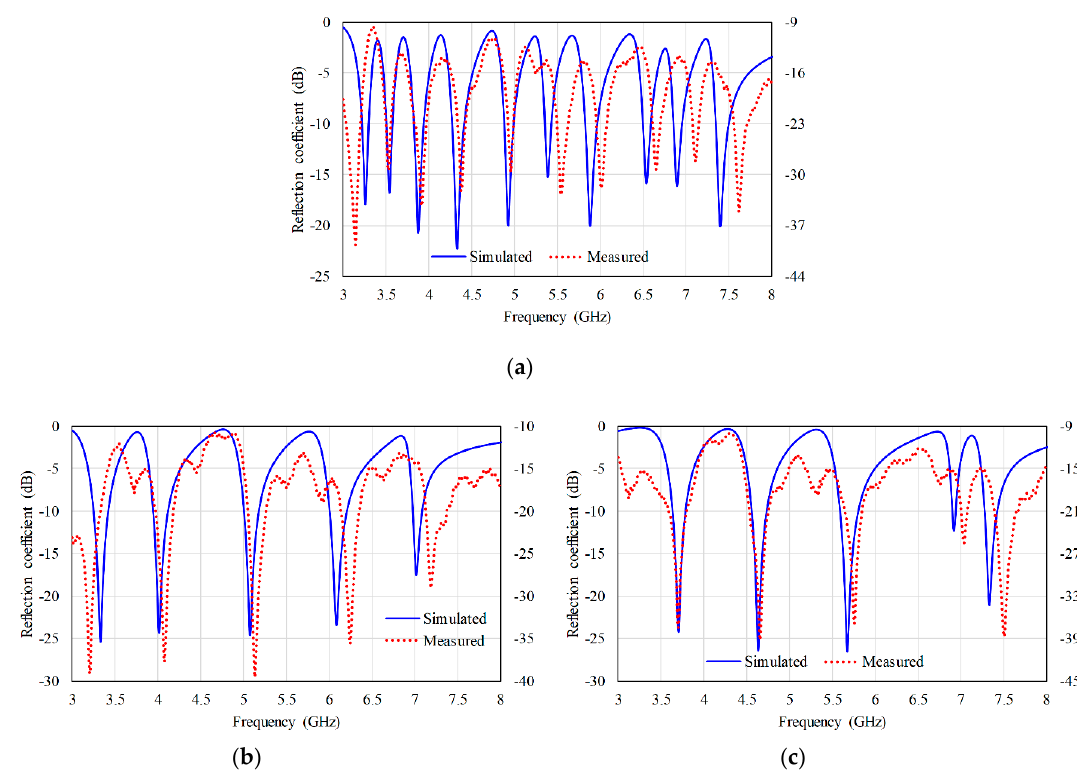
Figure 16. Simulated and measured S 11 under vertical polarization for 10 cm distance from the RFID reader: ( a ) ID: 11111111111111111111, ( b ) ID: 11001100110011001100, and ( c ) ID: 00110011001100110011.